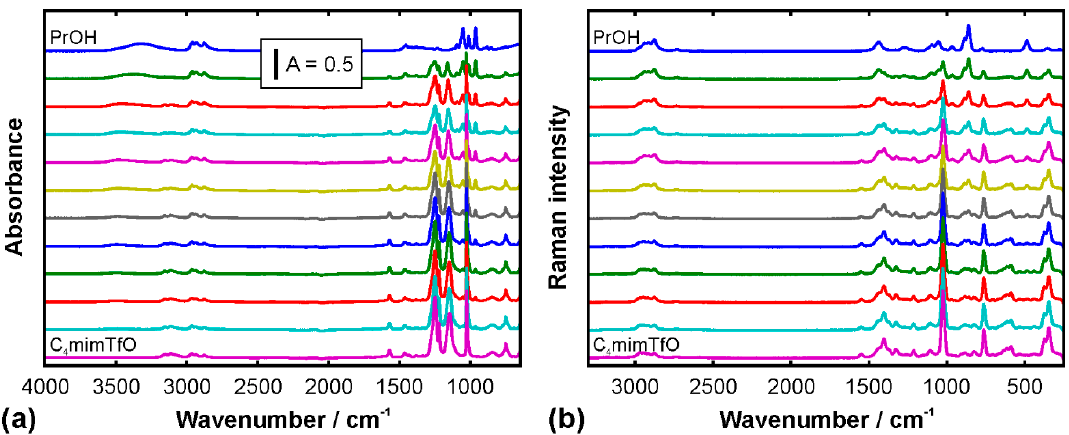
Figure 1. Attenuated total reflection (ATR)-FTIR spectra ( a ) and Raman spectra ( b ) of the neat substances and the binary mixtures.